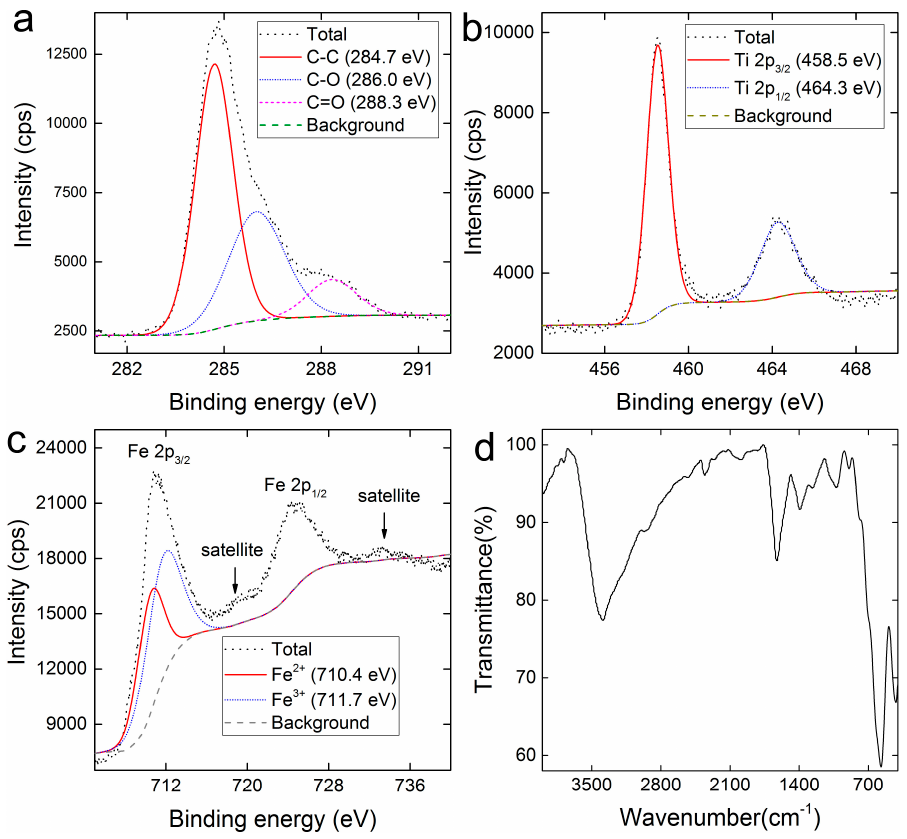
Figure 3. XPS and IR spectra of FTCNCs. ( a ) C1s XPS spectrum; ( b ) Ti2p XPS spectrum; ( c ) Fe2p XPS spectrum; ( d ) IR spectrum.